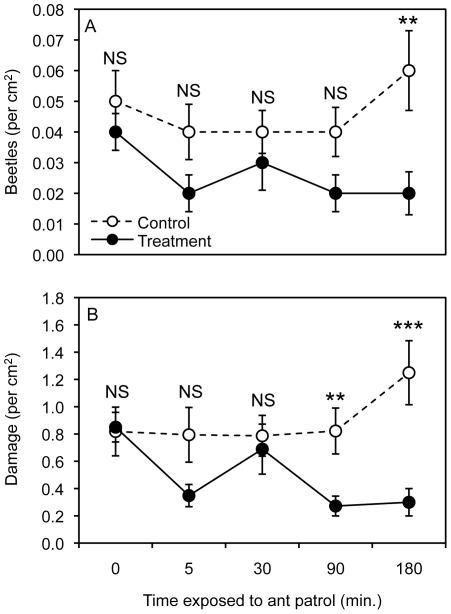
The effect of ant-treatment exposure-length on beetle choice and herbivory.Experiment 6 treatment means (± SE) for the number of beetles per cm2 (A) and damage marks per cm2 (B) on control leaves and leaves exposed to A. instabilis patrolling for 0-, 5-, 30-, 90-, and 180-min. prior to choice test. Statistical differences between ant and control treatment means are represented as: NS = P>0.05, * = P<0.05, ** = P<0.01, *** = P<0.001.